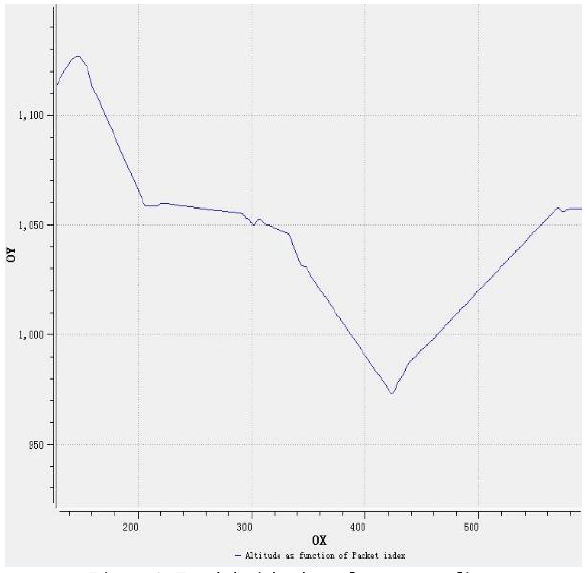
Figure 6. Track height data along power lines